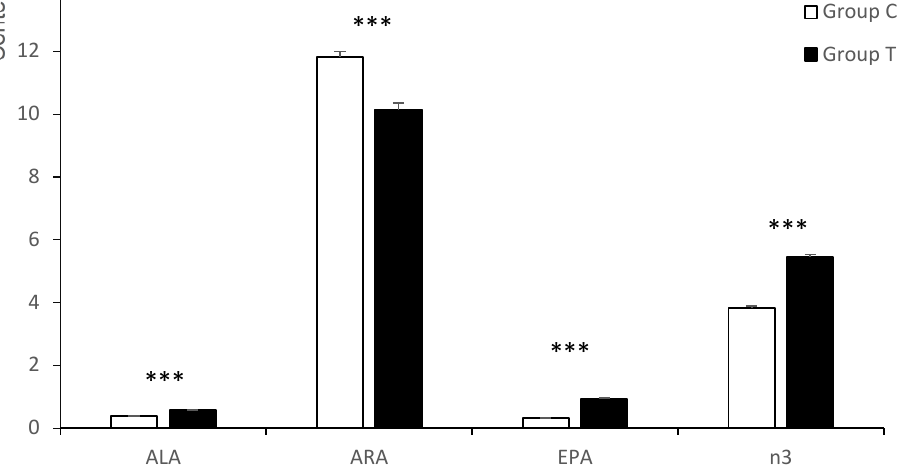
Figure 3. Significant differences in the n3 and n6-PUFA series of the polar fraction of the longissimus dorsi muscle between fetuses obtained at 100 days of gestation born from control gilts (group C) or from gilts treated with hydroxytyrosol and linseed oil from day 35 to day 100 of gestation (group T). ALA = α -linolenic acid; ARA = arachidonic acid; EPA = eicosapentaenoic acid; n3 = total sum of n3-Polyunsaturated fatty acid. *** p < 0.001.